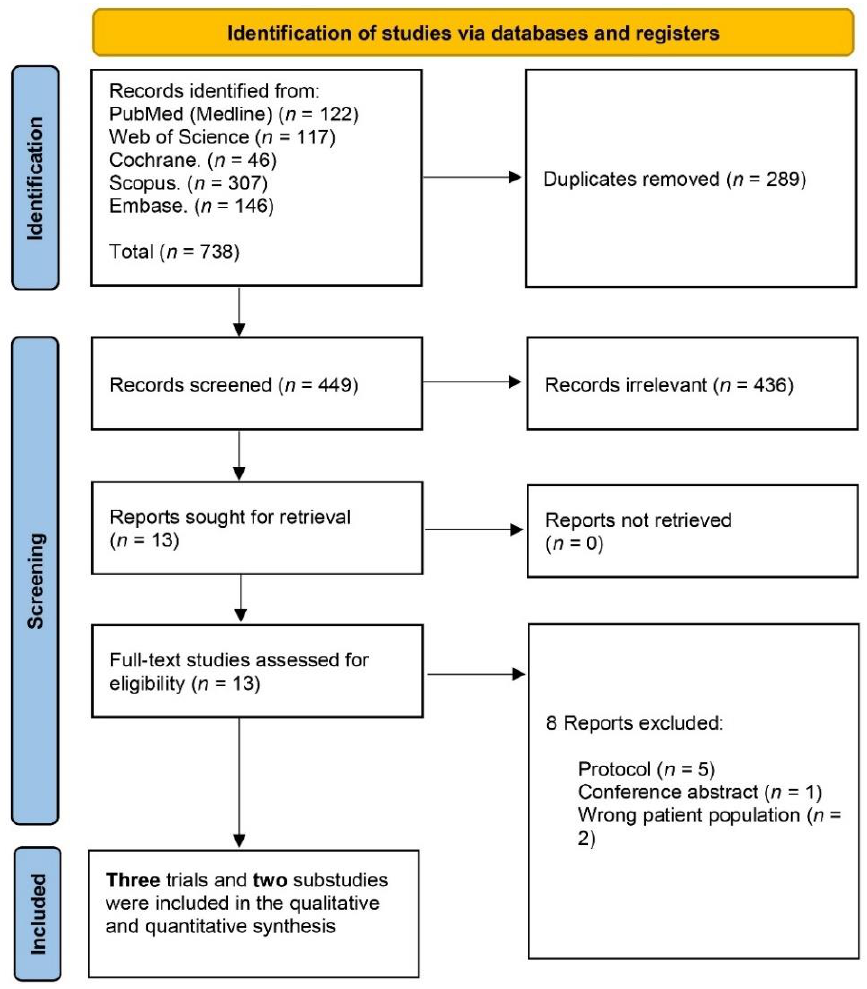
Figure 1. PRISMA flow chart of the screening process.